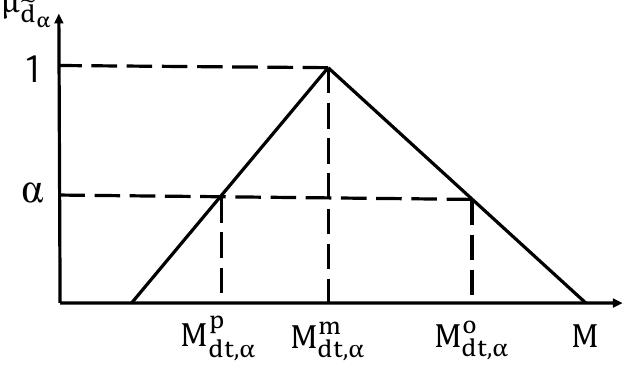
Figure 3. Fuzzy triangular